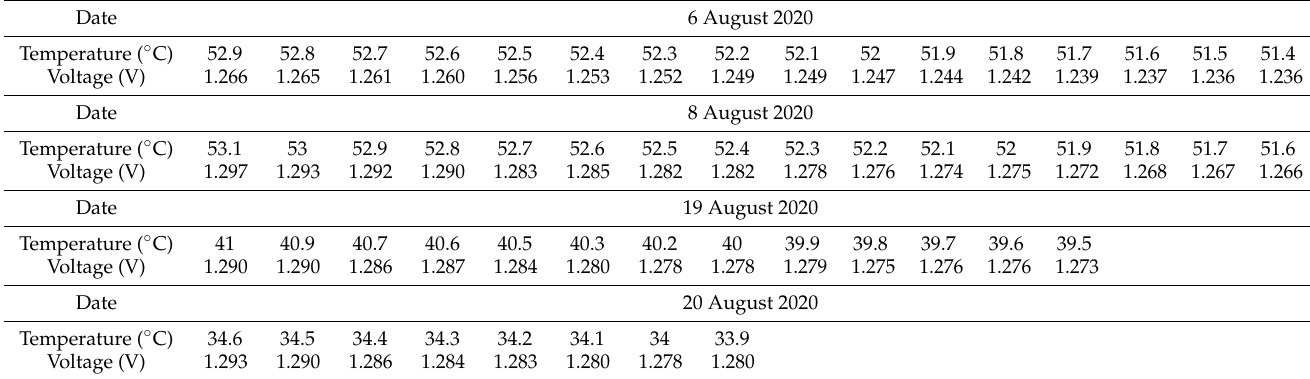
Table 1. Mean output voltage of microwave radiometer when measuring water at 33–55 ◦